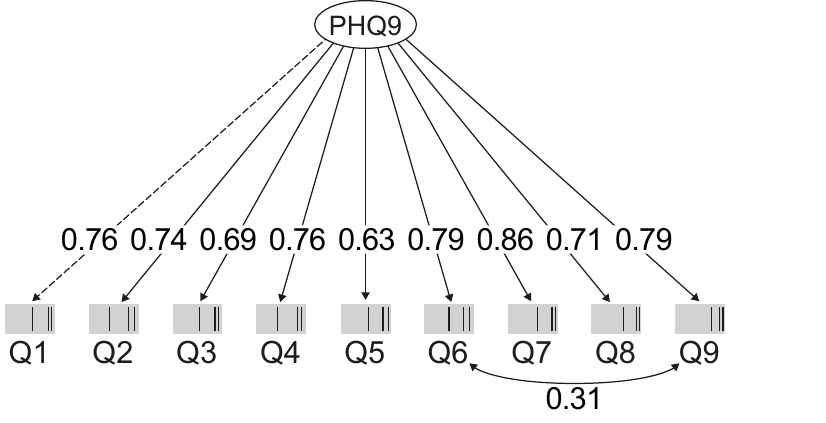
Fig 2. Confirmatory factor analysis models for